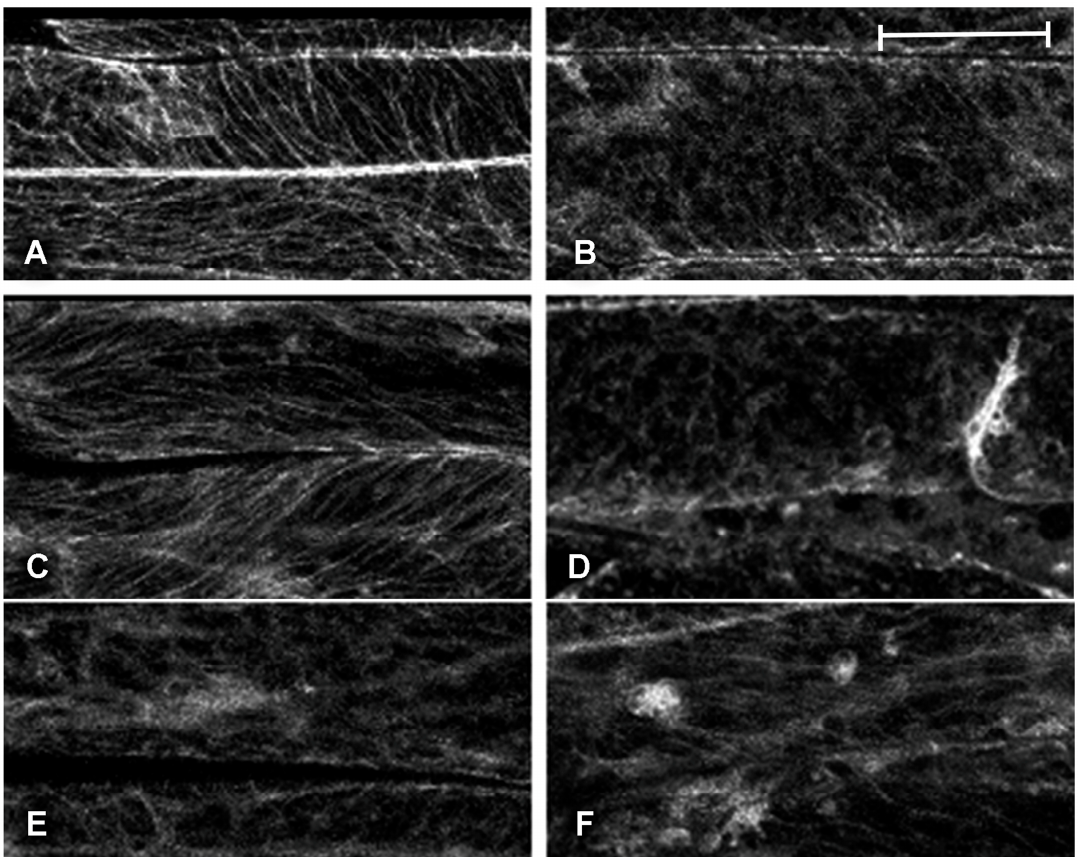
Figure 2. Fluorescent patterns of green fluorescent protein (GFP)-tagged microtubule-protein TUA6 (TUA6-GFP) microtubules marker in elongated petiole cells of transgenic Arabidopsis thaliana . ( A ) Normal fluorescent pattern of TUA6-GFP as observed after treatment with low drug doses (here 0.1 mg/L, 0.26 µM kiteplatin); ( B ) Perturbed microtubules after treatment with 1 mg/L, 2.5 µM, oxaliplatin; ( C ) Weak perturbation of microtubules orientation after treatment with 5 mg/L, 13 µM, kiteplatin; ( D ) Strong alteration due to treatment with 200 mg/L kiteplatin; ( E ) Clear alteration of TUA6-GFP distribution after treatment with 1 mg/L (3 µM); and ( F ) 200 mg/L (67 µM) cisplatin. Scale bar: 20 µm.